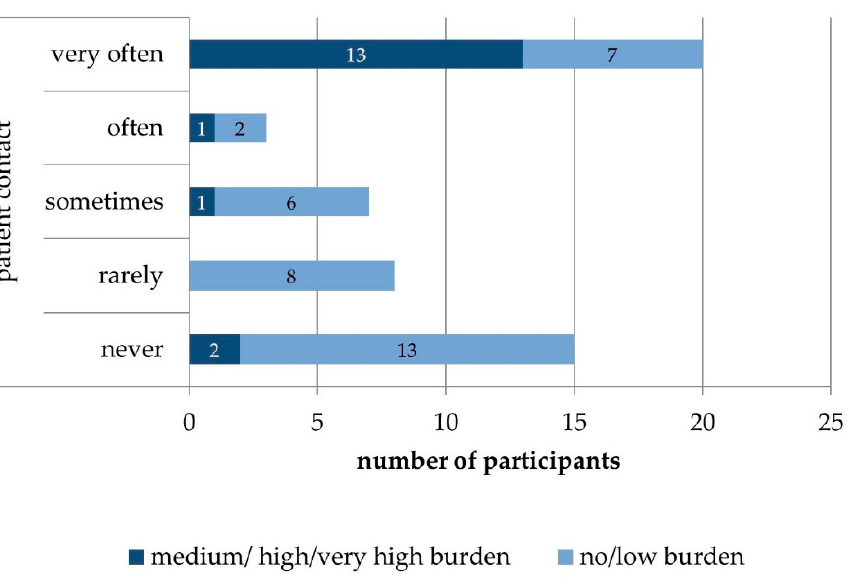
Figure 2. Burden by the topic death and dying at work in relation to the extent of patient contact (n = 53).